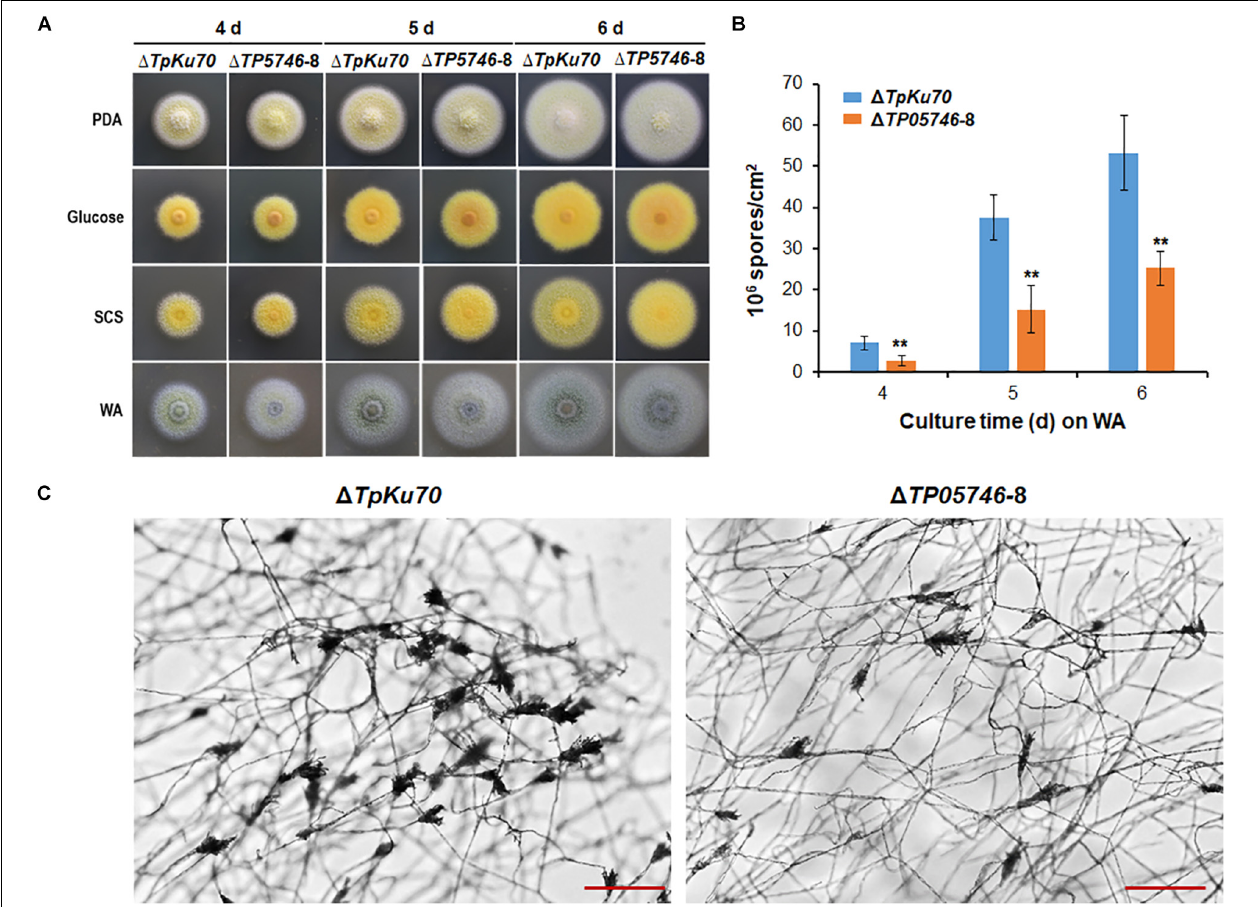
FIGURE 3 | Phenotypic analyses of T. pinophilus mutant (cid:49) TP05746 and the parental strain (cid:49) TpKu70 . (A) Colonies on solid LsMM plates containing glucose, SCS, or WA, with PDA being used for a positive control. Fungal strains were incubated at 28 ◦ C for 4–6 days. (B) Numbers of asexual spores on WA. Each data point is mean ± SD. ∗∗ p < 0.01 indicates differences between the (cid:49) TP05746 and parental strain (cid:49) TpKu70 by Student’s t test. (C) Microscopic investigation of conidiophores. Fungal strains were cultivated on WA at 28 ◦ C for 36 h. The mutant (cid:49) TP05746 exhibited fewer phialides in comparison with the parental strain (cid:49) TpKu70 . LsMM, low-salt minimal medium; SCS, soluble corn starch; WA, wheat bran plus Avicel; PDA, potato dextrose